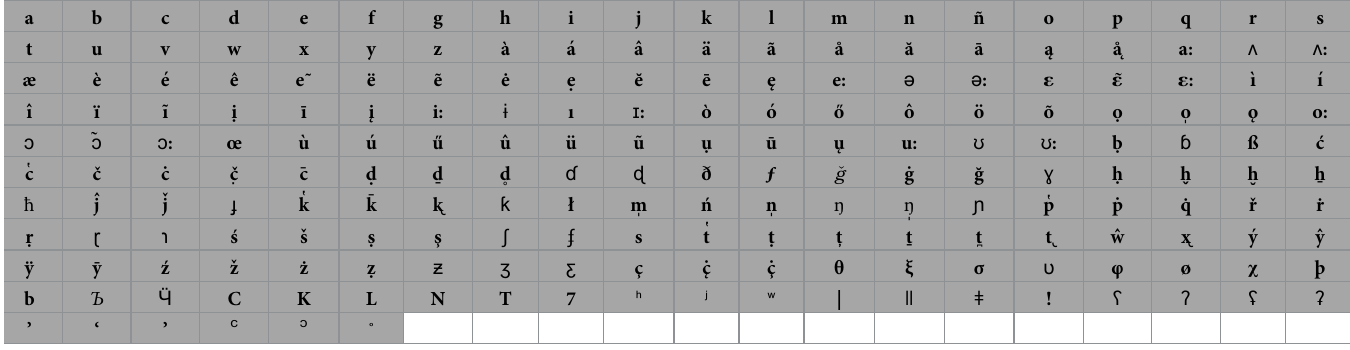
Table 2. Total set of graphemes.